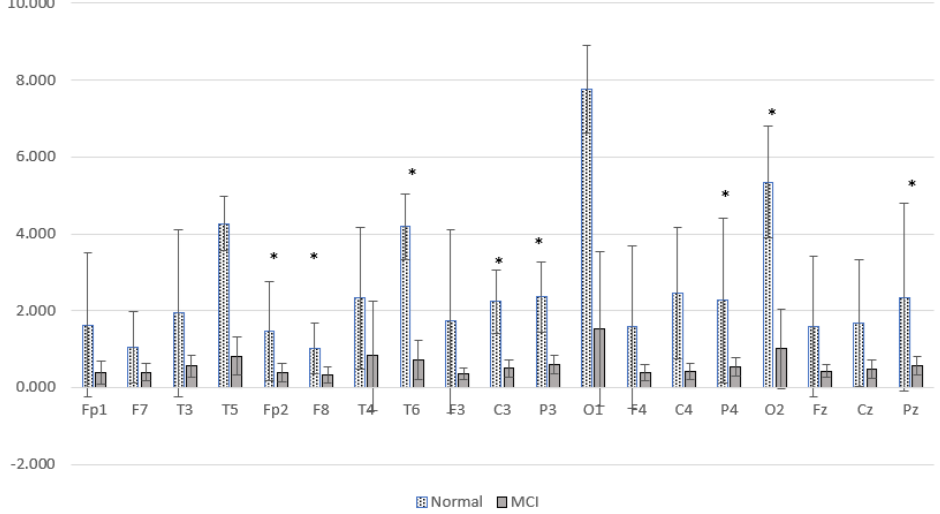
Figure 13. Comparison of the relative power of high and low frequency MCI and normal groups. * p < 0.05.